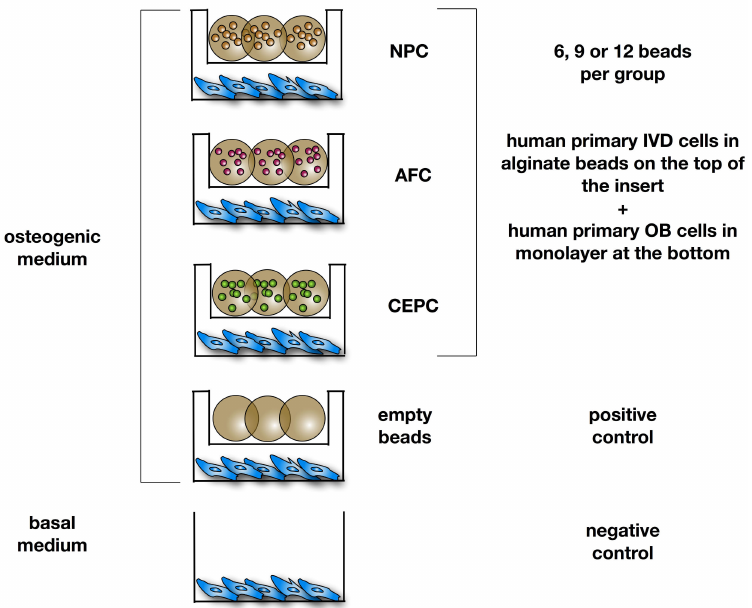
Figure 5. Experimental design of co-culture experiments of primary osteoblasts (OB) with either nucleus pulposus cells (NPC), annulus fibrosus cells (AFC), cartilaginous endplate cells (CEPC) or 6 empty beads as positive control. OB were cultured as monolayer at the bottom of the well, intervertebral disc (IVD) cells were seeded in 3D alginate beads (~30 µ L) on the top in the insert with 0.4 µ m pore size. All experimental groups and positive control were stimulated with osteogenic medium ( α -MEM supplemented with 10% FBS, 100 µ g/mL penicillin/streptomycin, 50 µ g/mL L -ascorbic acid-2-phosphate, 10 nM dexamethasone and 5 mM β -glycerophosphate). Negative control was stimulated with basal medium ( α -MEM + 10%